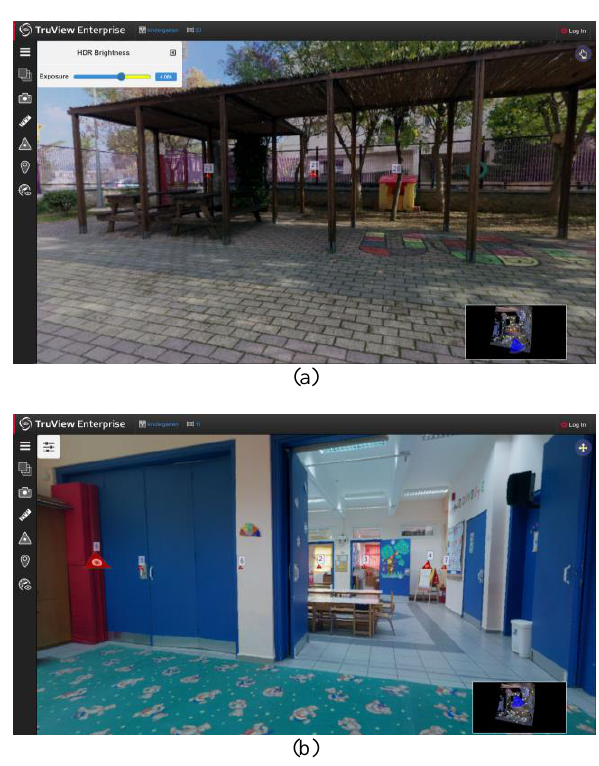
Fig. 5. Views of the model within TruView (a) outdoor area (HDR layer) (b) internal area of school (RGB layer)